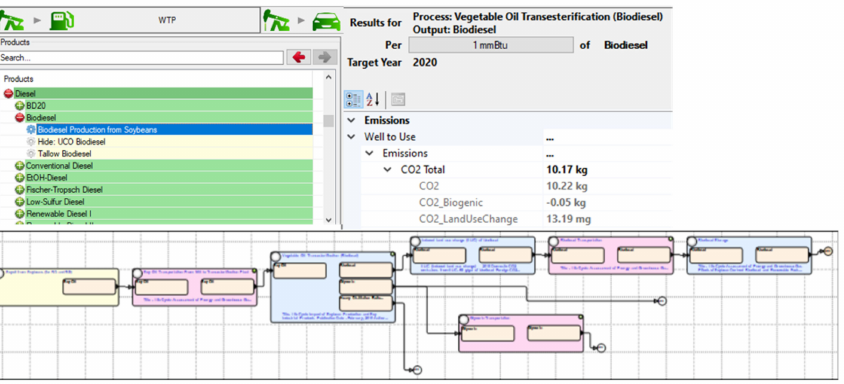
Figure 4. Biodiesel production from soybeans (produced in GREET